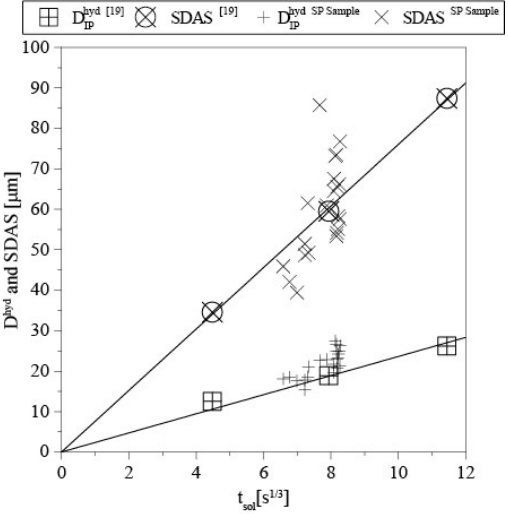
hyd D of the intradendritic space of the intradendritic space IP IP